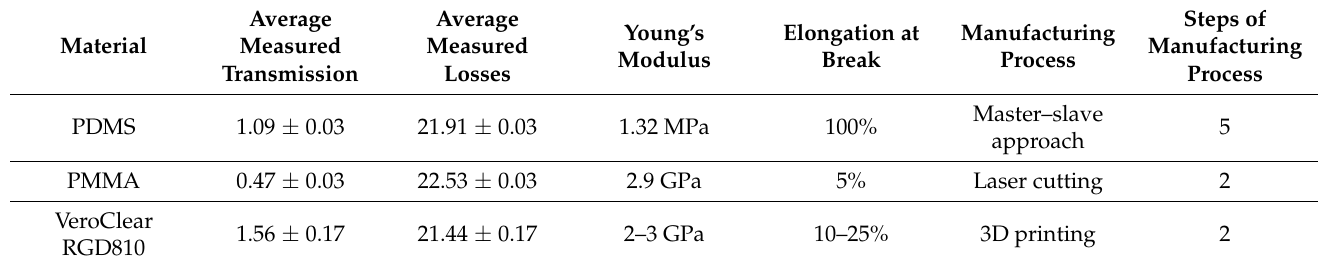
Table 1. Comparative analysis between the PDMS- µ SPT , the PMMA- µ SPT , and the VeroClear- µ SPT in terms of optical properties, mechanical properties, and manufacturing